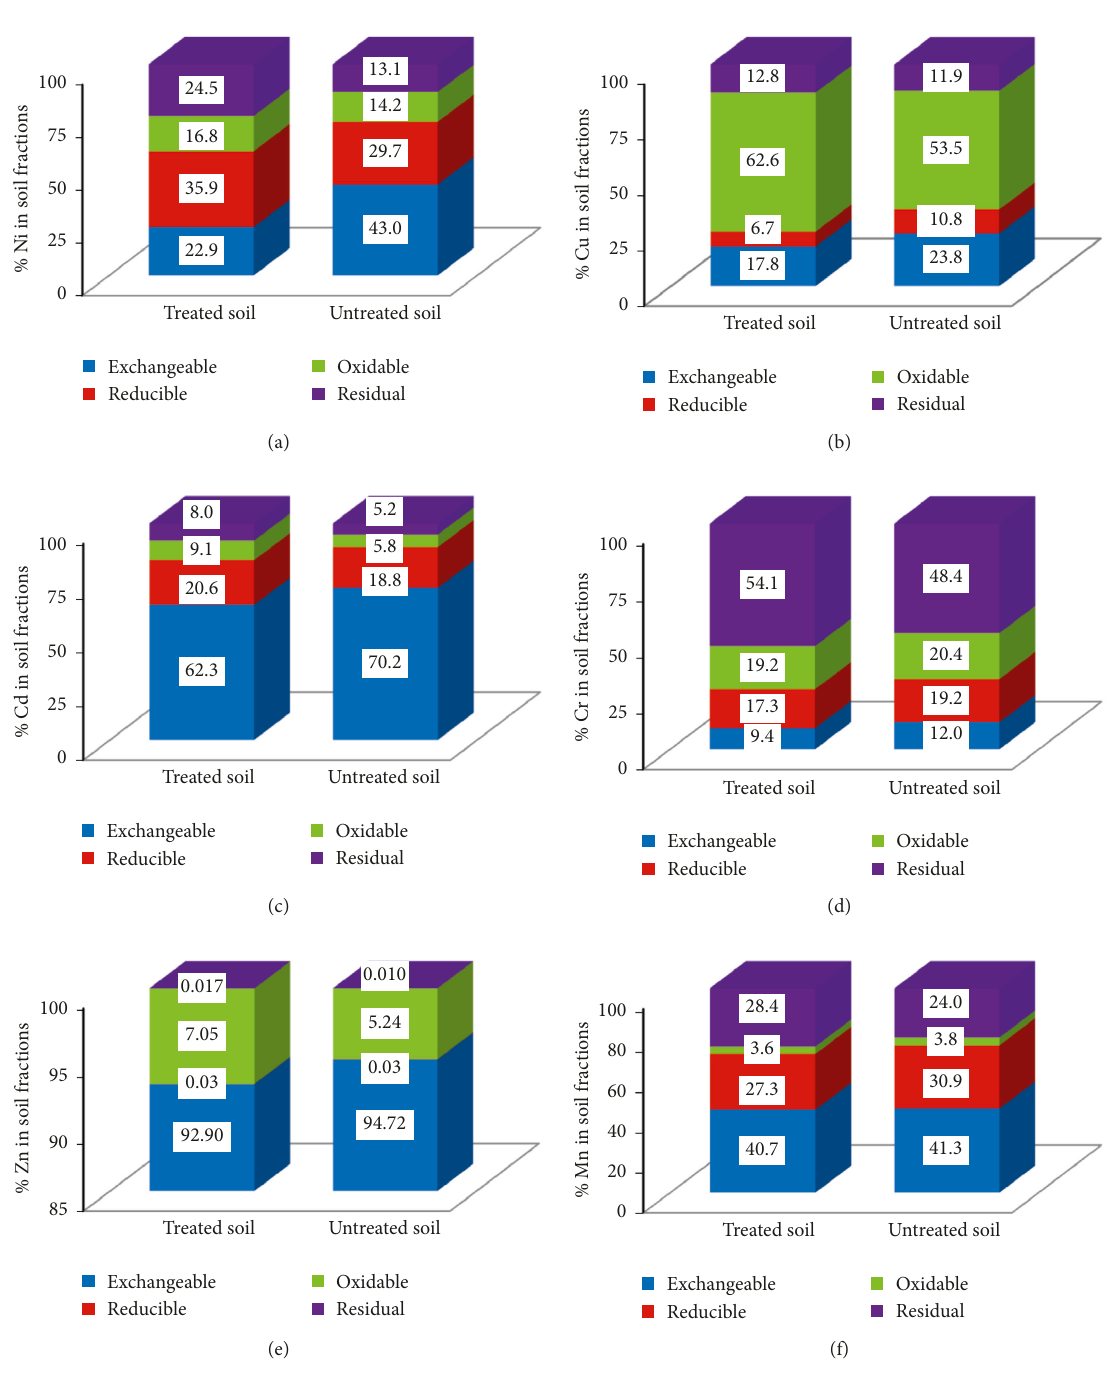
Figure 8: Distribution of heavy metals in soils after treatment (T) using 2g of soil and 5mL of MCNPs at pH 6.58 and without treatment (UT): (a) Ni, (b) Cu, (c) Cd, (d) Cr, (e) Zn, and (f)